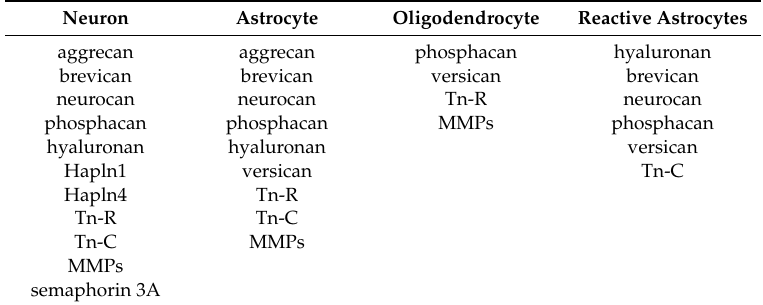
Table 1. Sources and location of perineuronal nets (PNNs) components [2]. Neurons, astrocytes, oligodendrocyte, reactive astrocytes provides PNNs build components and interacting proteins: glycosaminoglycans (GAGs), proteoglycans (PGs); linkage proteins; metalloproteases (MMPs); signaling proteins.